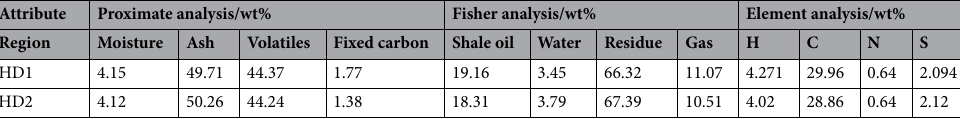
Table 1. Analysis of oil shale in Huadian.